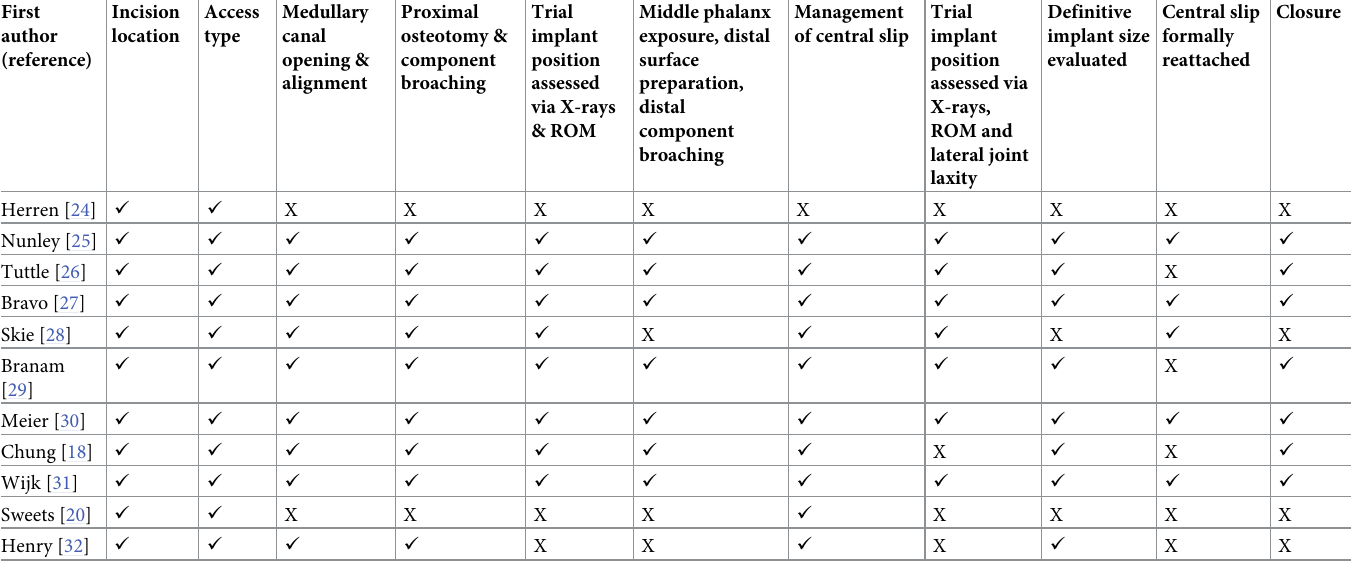
Table 4. Reporting of the key components of pyrocarbon PIPJ arthroplasty in included